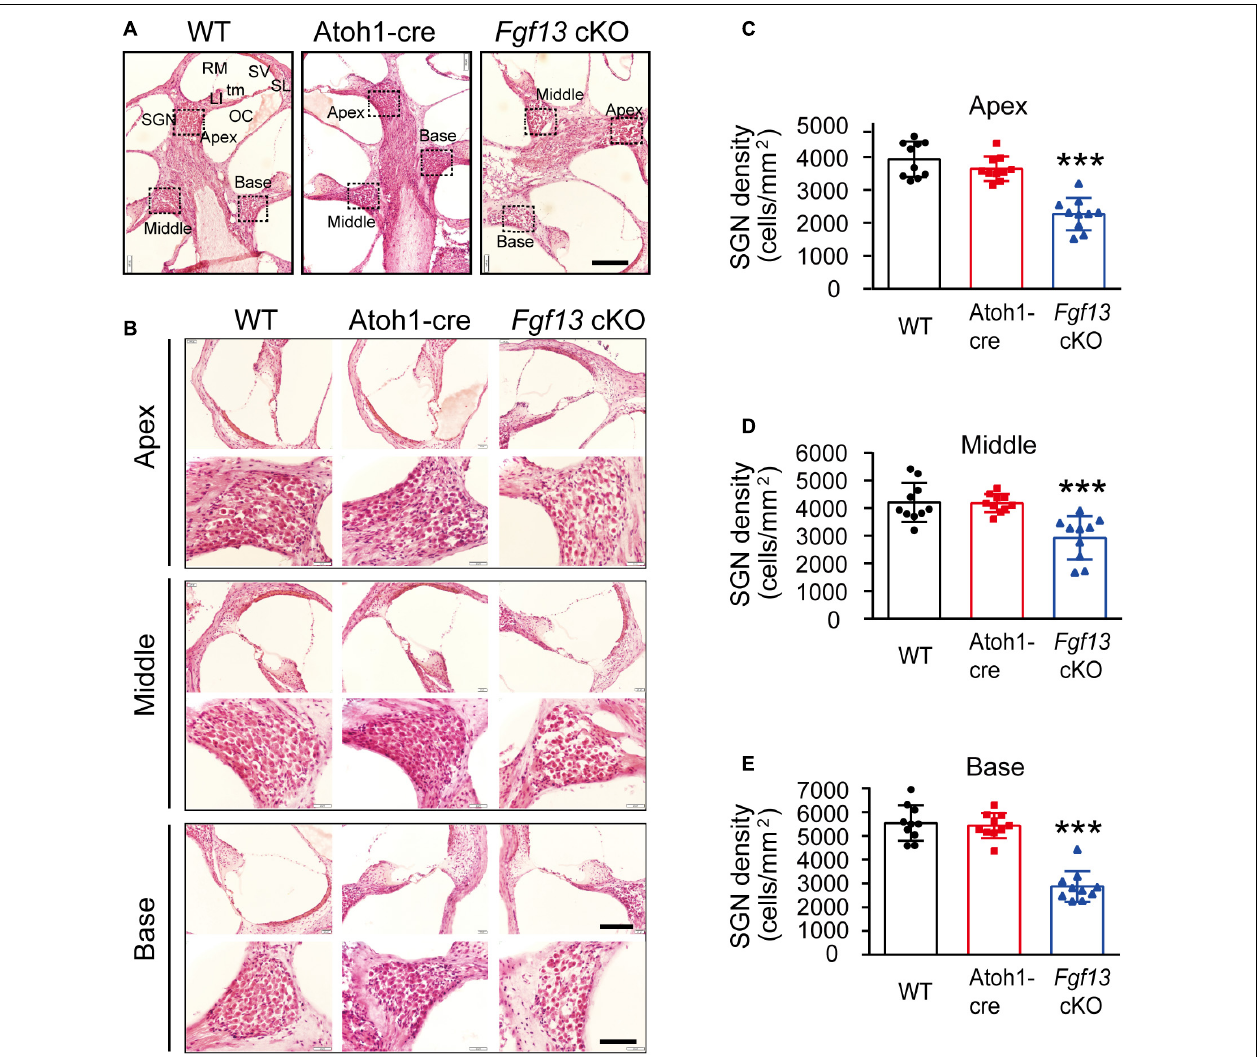
FIGURE 5 | Fgf13 knockout causes the loss of SGNs with normal morphological structure of the cochlea in the mice. (A) Modiolar cochlear sections depicting the apex to the base stained by hematoxylin-eosin. SGN, spiral ganglion neuron; LI, spiral limbus; OC, organ of Corti; tm, tectorial membrane; RM, Reissner’s membrane; SV, stria vascularis; SL, spiral ligament. (B) OC (top) and SGN (bottom) are shown at higher magnification. (C–E) Quantitative analysis of SGNs densities from the apex to the base. n = 10/WT (6 M, 4 F); n = 10/Atoh1-cre (7 M, 3 F), n = 10/ Fgf13 cKO (7 M, 3 F). Scale bar: G = 100 µ m, Scale bar: H = 80 µ m (top), and Scale bar: H = 40 µ m (bottom). F, female; M, male. *** P < 0.001 compared to controls as determined by One-Way